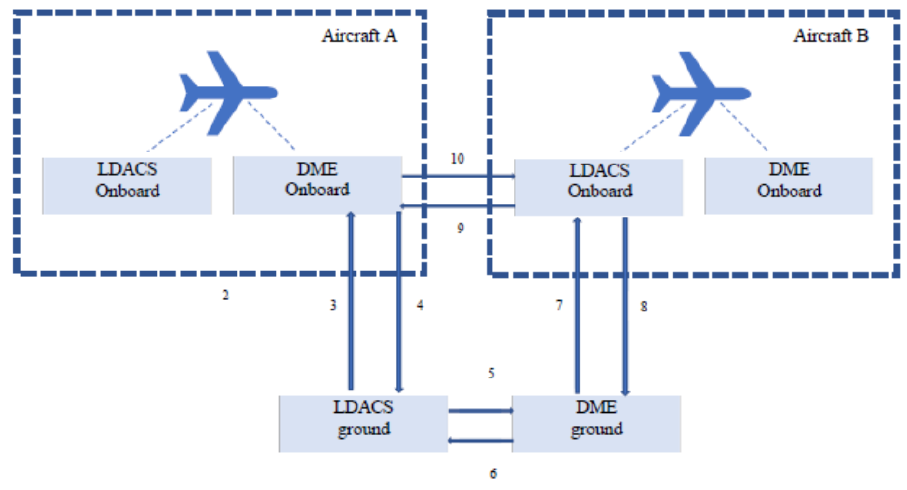
Figure 2. Interference Between DME and LDACS